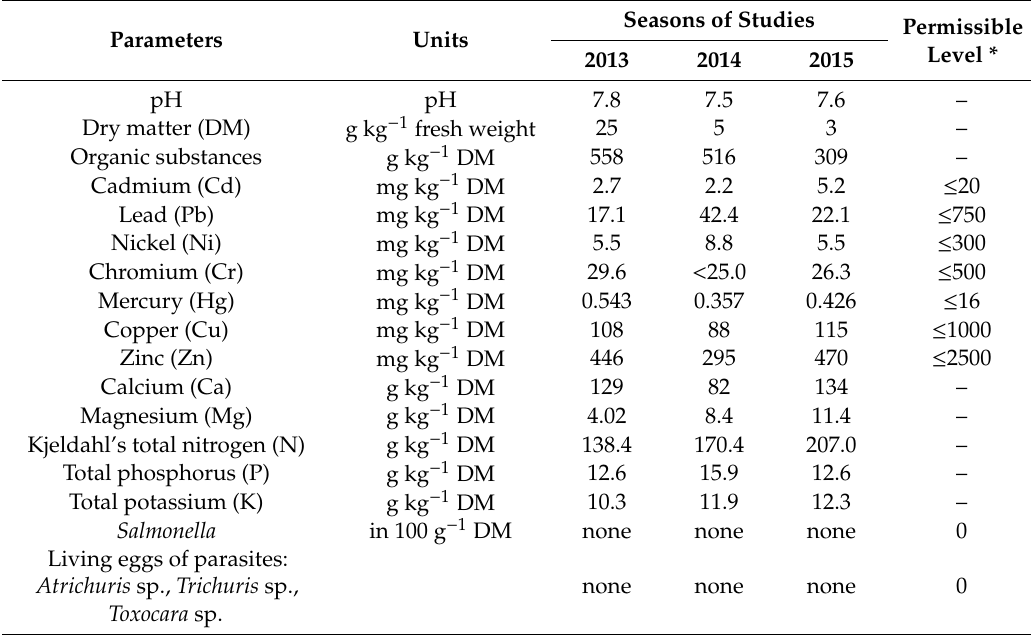
Table 1. Quality parameters of digestate applied in the experiment on the background of permissible level of potential pollutants allowing soil application of sewage sludge in crop